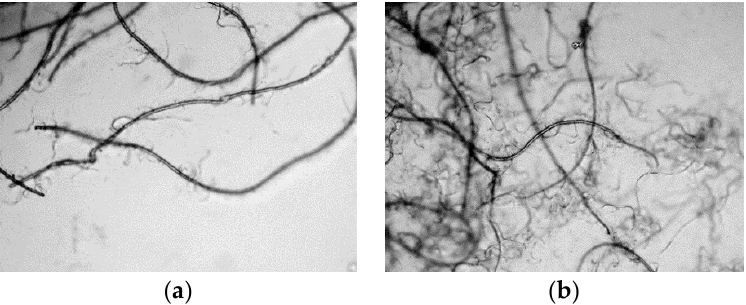
Figure 3. Microscopic images (×100) of the fibrillated Lyocell fiber under refining pressure of 1.00 N/mm: ( a ) 10,000 revolutions; ( b ) 40,000 revolutions.